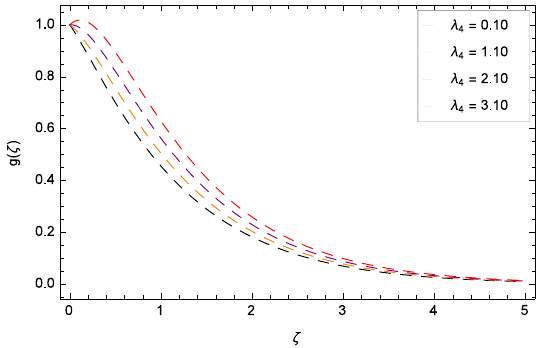
Figure 11. Pattern of graph curves on account of (cid:31) 4 .